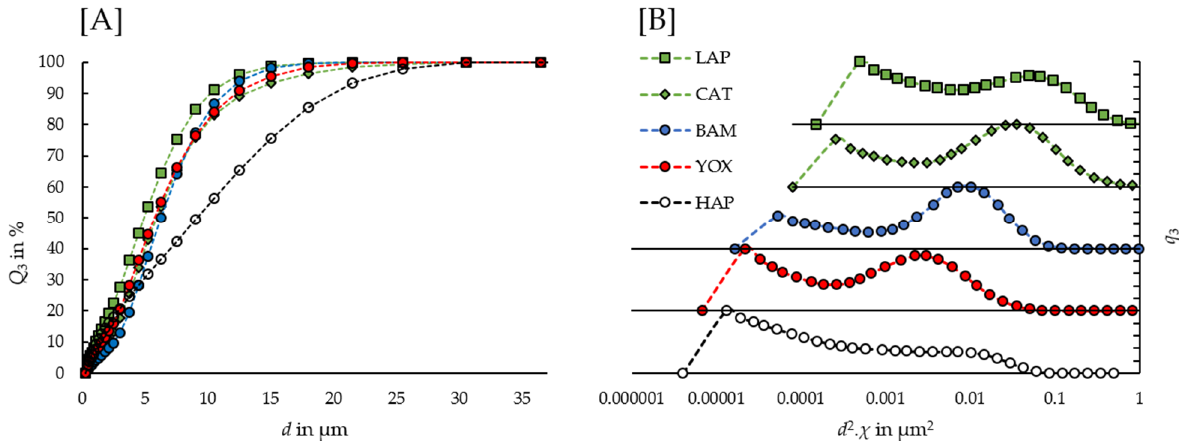
Figure 5. ( A ) Cumulative volume weighted PSD of the phosphors, as determined by laser diffraction analysis. ( B ) Volume weighted PSD of the phosphors in function of the particle-dependent component of the magnetophoretic velocity.